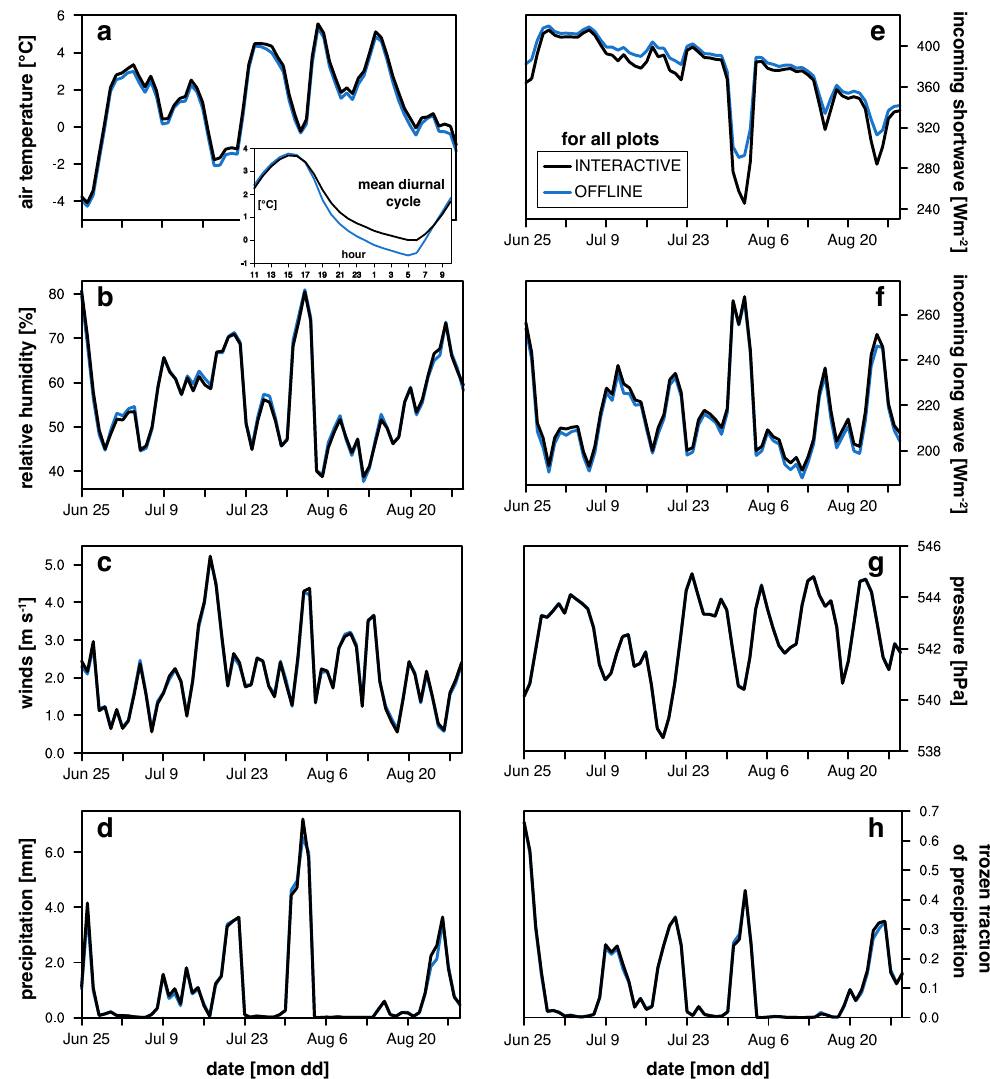
Fig. 5. Daily mean (a) air temperature, (b) relative humidity, (c) wind speed, (d) total precipitation, incoming (e) normal short-wave and (f) downward long-wave radiation at ground surface, (g) air pressure, and (h) frozen fraction of precipitation, area-averaged over all glaciated grid cells. Data for (a–c) , and (g) are taken from the lowest model level ( z = 20m). The subpanel in (a) presents the average diurnal temperature cycle over the simulation period. Black (blue) curves display data from the interactive (offline)